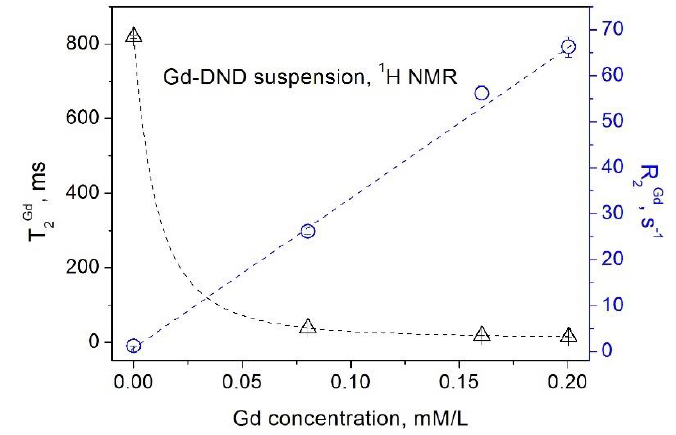
Figure 4. Dependence of the spin – spin relaxation rate R 2 (circles) [16] and the spin – spin relaxation time T 2 (triangles) of water protons in aqueous Gd-DND suspensions on the Gd 3+ ion concentration. Therefore, the proton spin – lattice and spin – spin relaxation times reveal a hyperbolic dependence on Gd C :